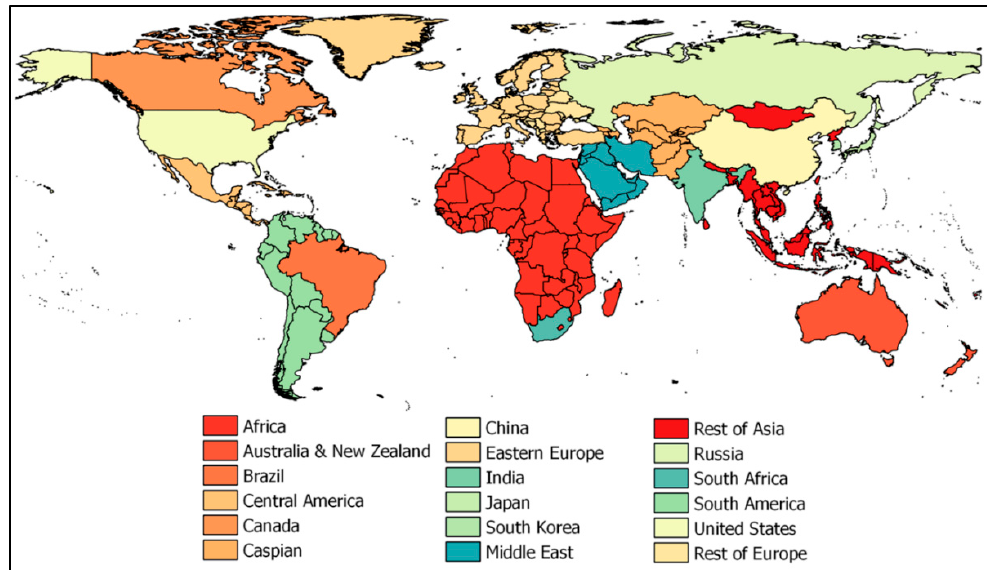
Figure A1. Regional breakdown of the COFFEE ‐ TEA IAM suite. The COFFEE ‐ TEA suite is included in the category of IAMs that combines techno ‐ economic and environmental variables to generate a cost ‐ optimal solution in a hybrid ap ‐ proach; bottom ‐ up technological solution with top ‐ down macroeconomic consistency.